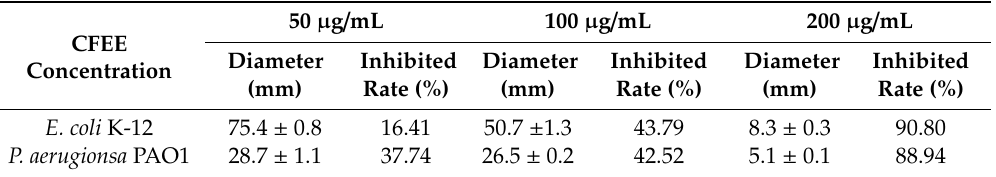
Table 2. Inhibition rates of planktonic circle by different concentrations of CFEE.